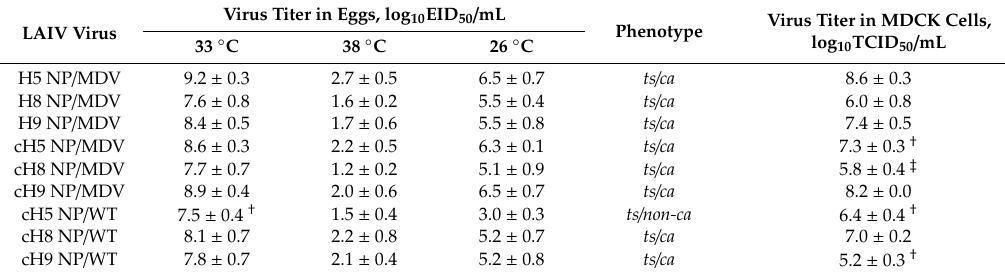
Table 1. Virological characteristics of LAIV viruses used in this